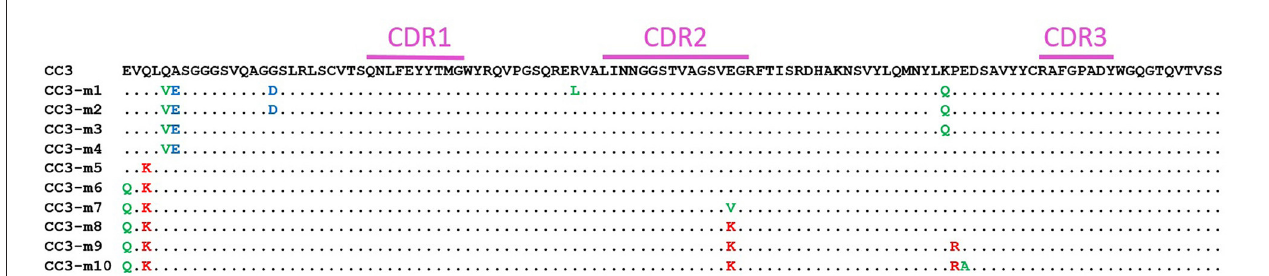
FIGURE 2 | Amino acid sequence (single letter abbreviation) of CC3 and the variants. The CDR regions are indicated by a purple bar. Unchanged amino acids are indicated with a dot. Substitutions to negative amino acids are in blue, substitutions to uncharged amino acids are in green, and substitutions to positively charged amino acids are in red.